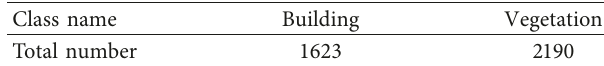
Table 2: Training data statistics.